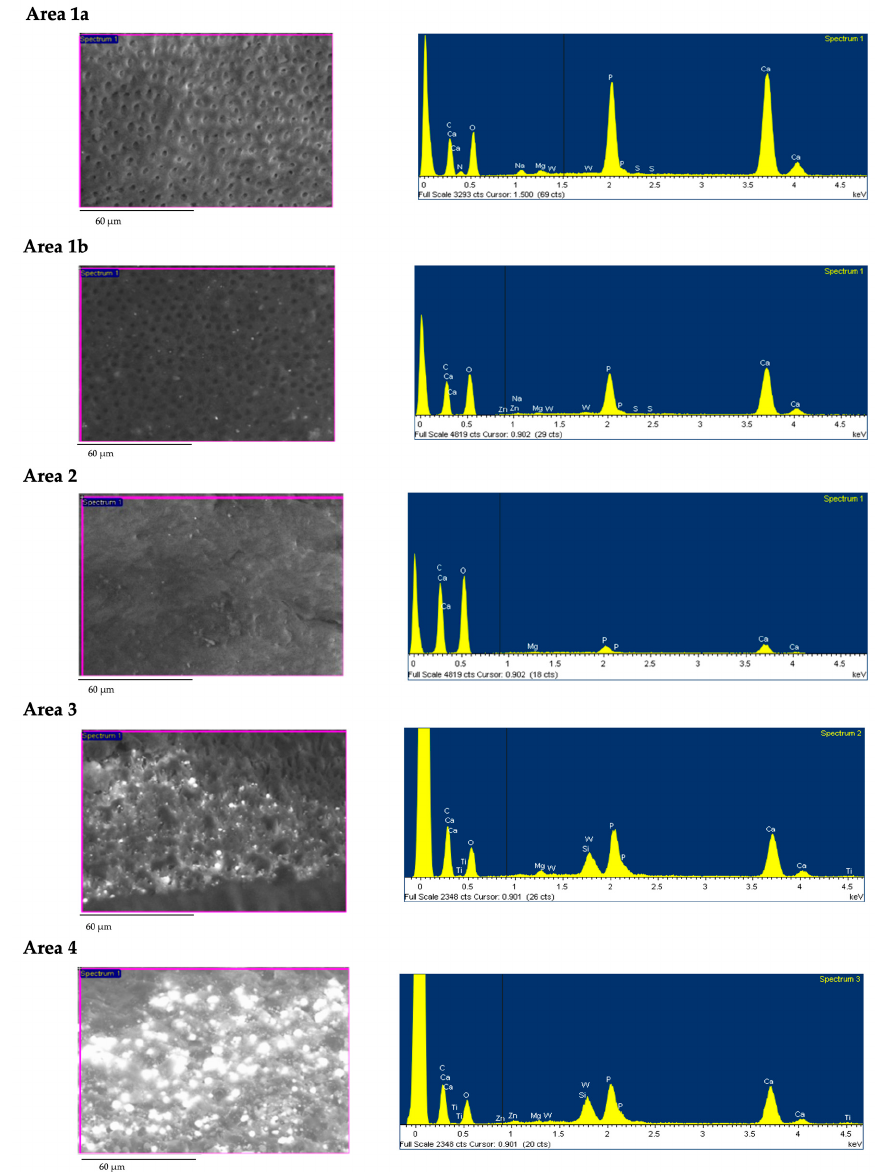
Figure 4. Dentine areas identified on root canal walls of secondary root canal treatments performed in the present study. The presence of specific elements inside the composition of sealer or gutta-percha (i.e., Zr, W, Zn etc.) was used as trace element to confirm the remnant presence (i.e., sealer or gutta-percha, or dentin smear